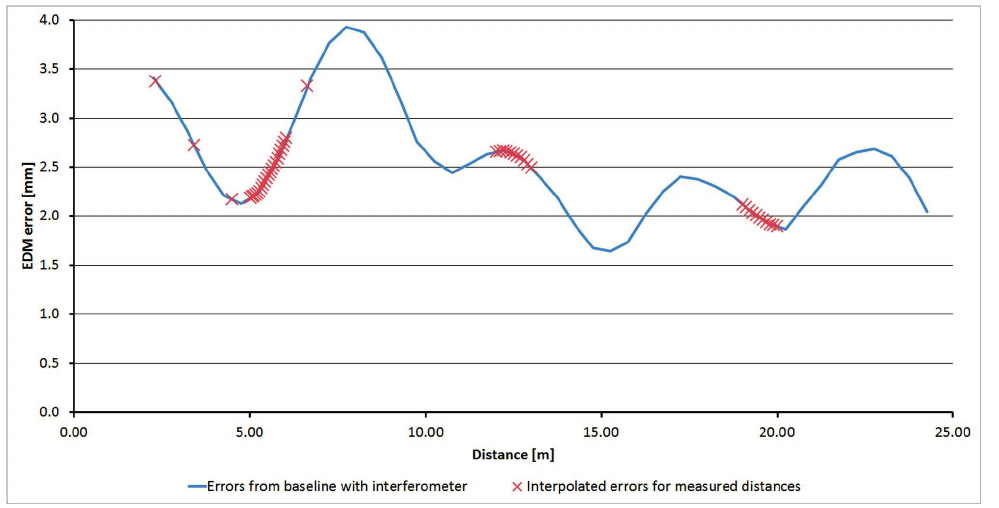
Figure 36. Interpolated corrections of the measured distances–Trimble M3.